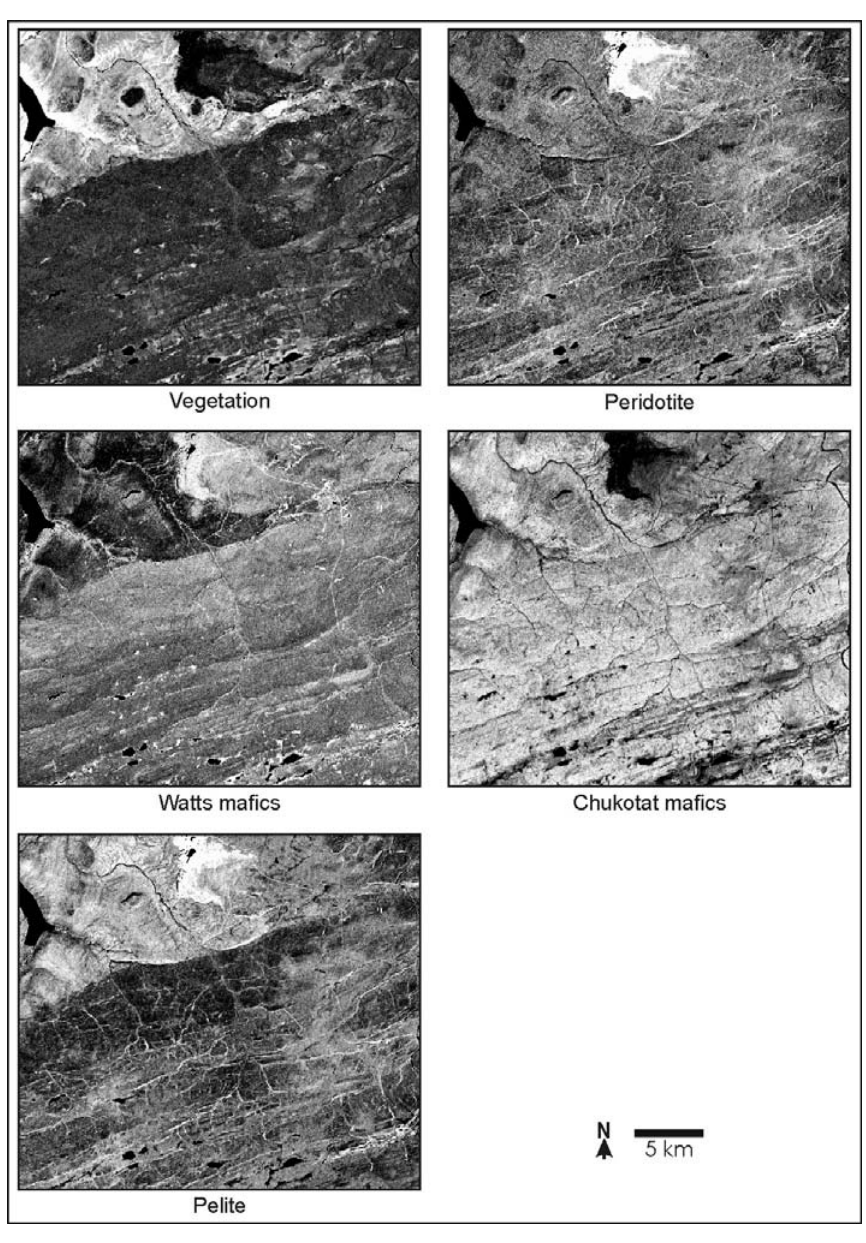
Figure 12. Fraction images generated by the unmixing of TM reflectance data on the basis of five end members. White and black correspond to 70% and 0% exposure,